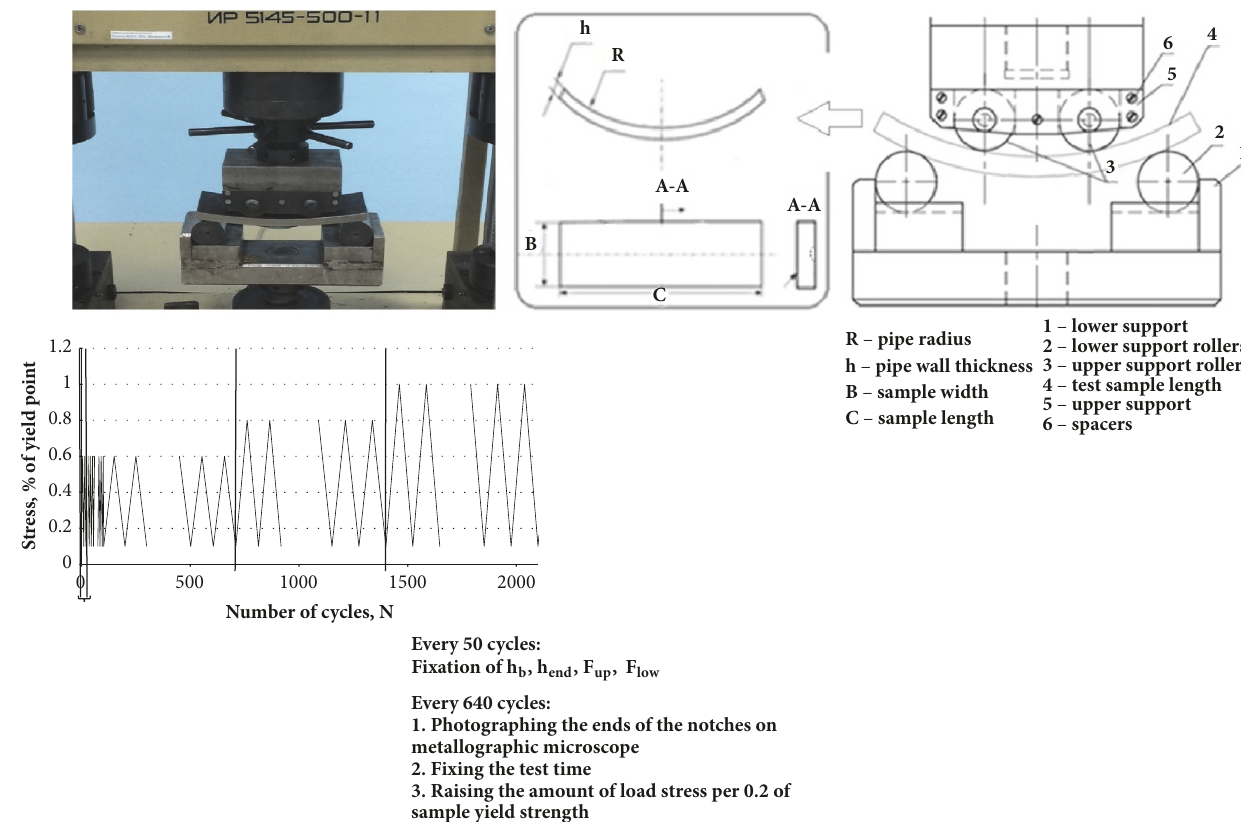
Figure 4: Cyclic testing of samples according to the four-point loading scheme.